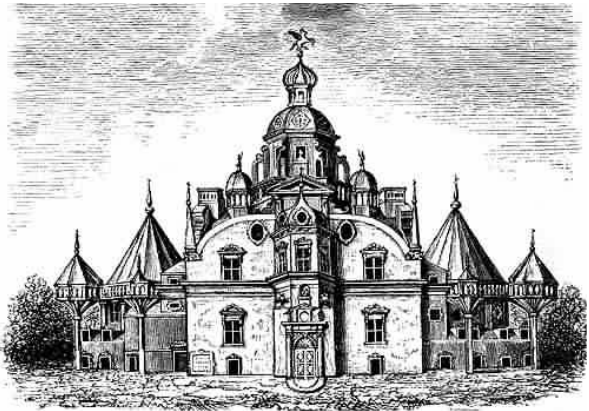
Figure 2. Tycho Brahe’s astronomical Observatory at Hven: Uranienborg (from J. Ottosen, Nordens Historie, 1902).